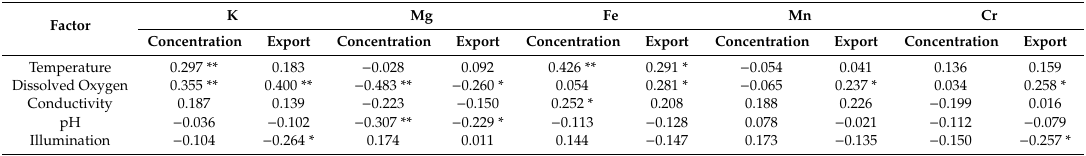
Table 3. Correlation coe ffi cients ( r ) between the environmental factors and the concentrations and exports of metals in the